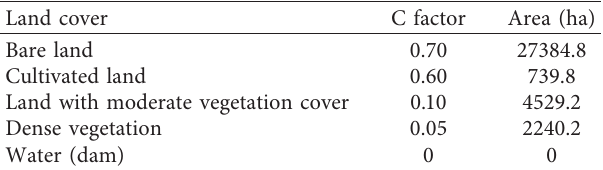
Table 2: Factor C classification depending on the land use type.